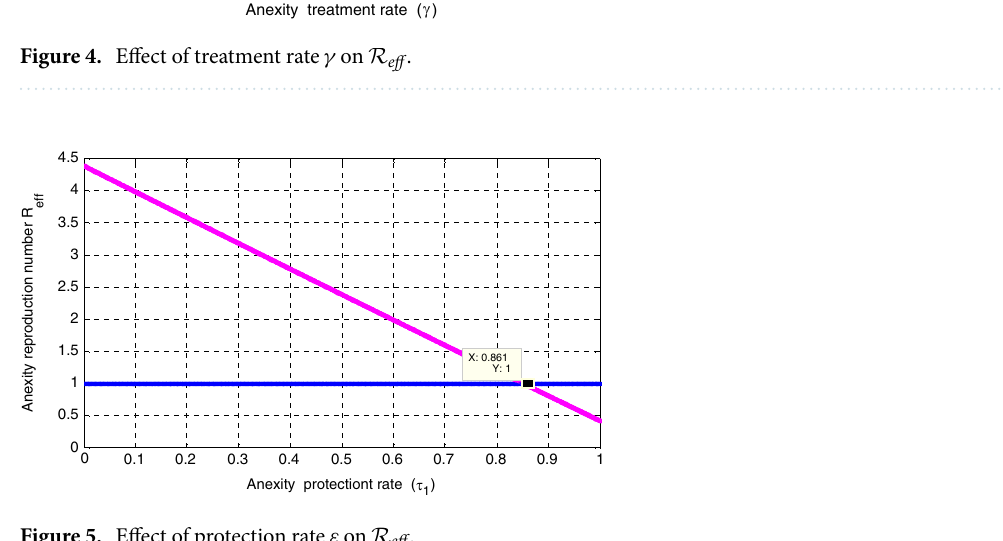
Figure 5. Effect of protection rate ε on R eff